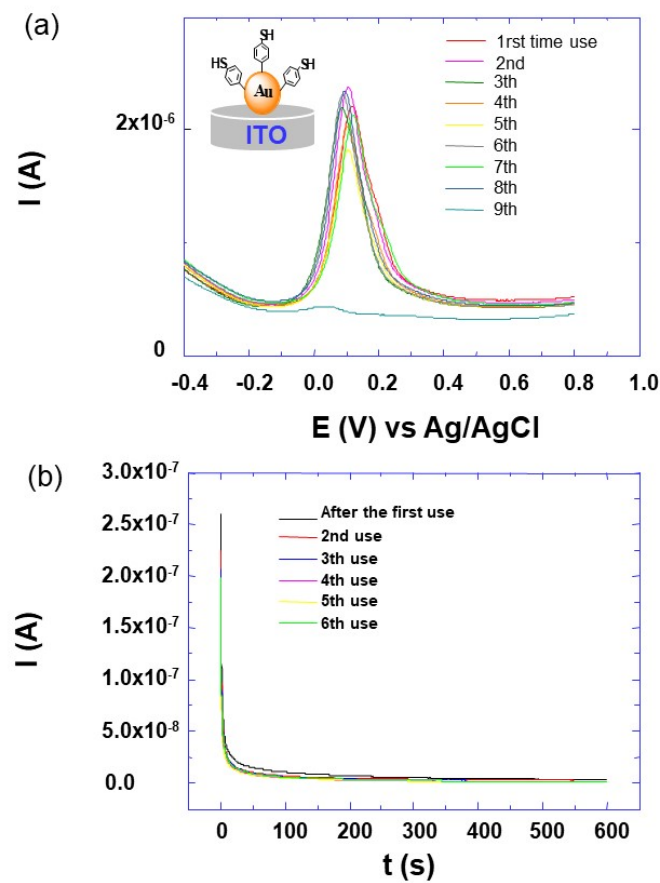
Figure 11. ( a ) SWV voltammograms of the ITO-AuNP-TPh electrode architecture as indicated in the inserted sketch, after different cycles of SWV detection and regeneration. The measurements were recorded with a scan rate of 10 mV s − 1 , in aqueous solution of KNO 3 (10 − 1 M) and copper salt (CuSO 4 , 10 − 6 M), ( b ) Current-time characteristic after the regeneration process of the same sensor based on the ITO-AuNP-TPh electrode architecture in the electrolyte aqueous solution of KNO 3 (10 − 1 M) at potential of + 0.4 V after each SWV experiment.